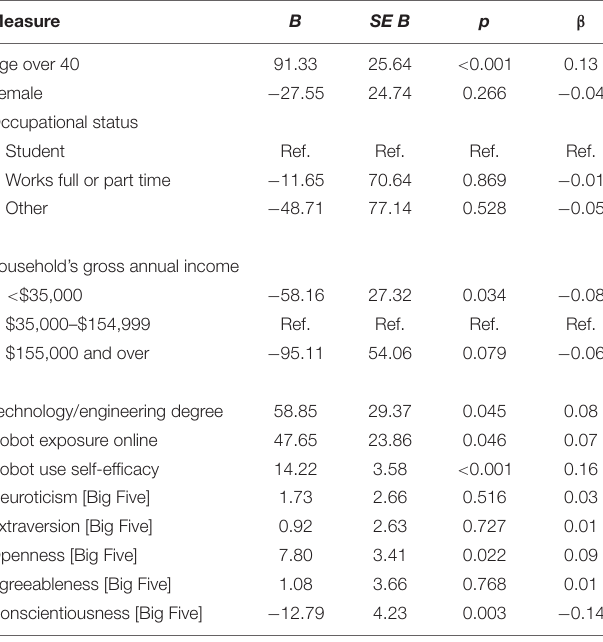
TABLE 3 | Descriptive statistics of independent variables used for regression analyses ( N = 720).